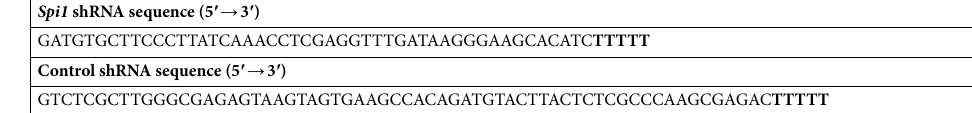
Table 1. shRNA sequences including termination sequence